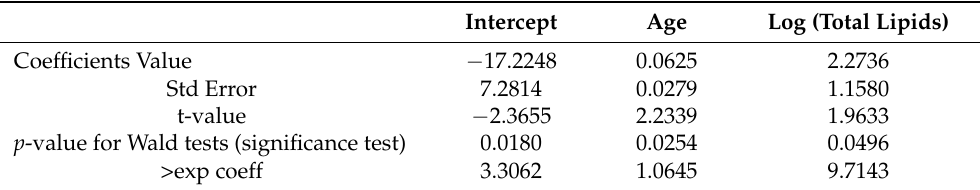
Table 6. Logistic regression: statistical results.